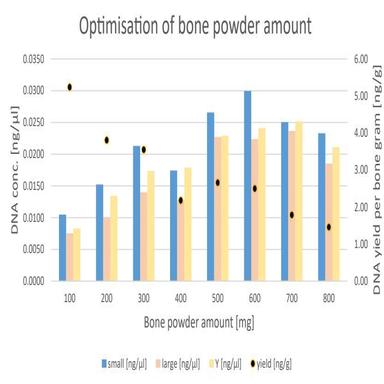
Results (arithmetic mean of two samples) of DNA concentration measurements (small autosomal DNA, large autosomal DNA, Y DNA) for the 8 variants of bone powder weight used for isolation. The obtained DNA yield per bone gram is also plotted on the graph.